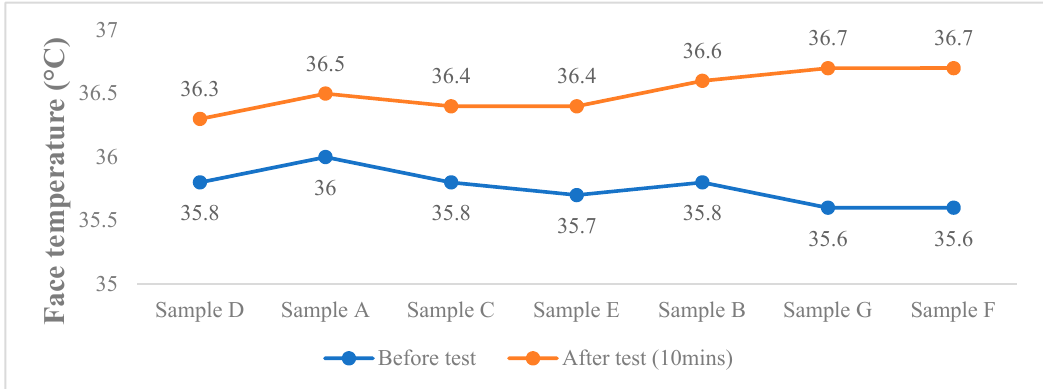
Table 3. Correlation between different test results.